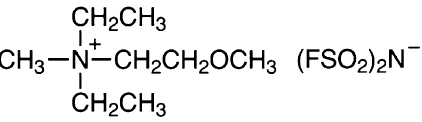
Figure 6. Molecular structure of (Diethyl (2-methoxyethyl)-methyl ammonium bis(fluorosulfonyl)imide)